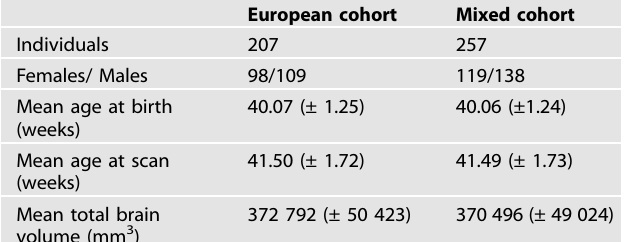
Fig. 2 Term-born European and Asian neonatal cohorts. Gestational age at birth (GA) and postmenstrual age at scan (PMA) distribution across European and Asian cohorts. Table 1. Demography of European and European and Asian (mixed)